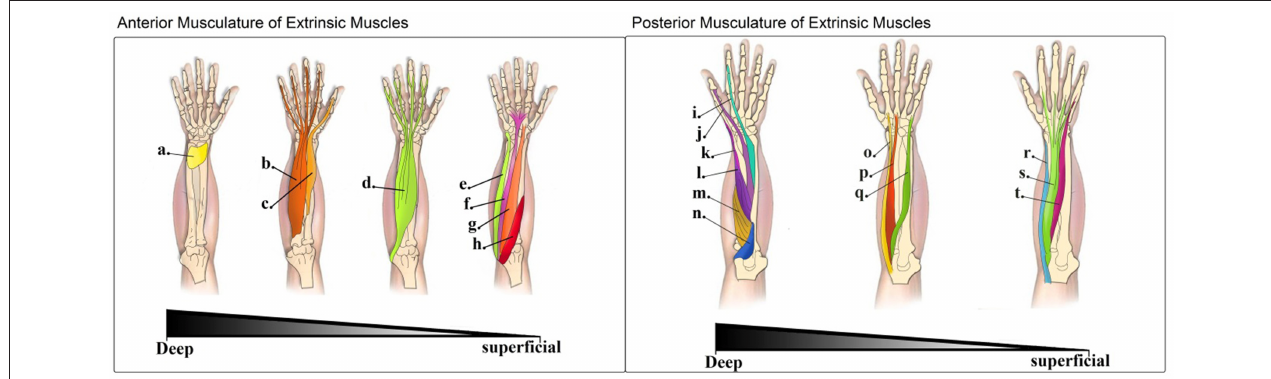
FIGURE 1 | Left: Muscles in the anterior compartment of extrinsic muscles (flexor muscles of the forearm)—The muscles of the anterior compartment of the forearm are depicted in this image from the deepest layer (left) to the most superficial one (right): (a). Pronator quadratus (PQ); (b). Flexor digitorium profundus (FDP); (c). Flexor pollicis longus (FPL); (d). Flexor digitorium superficialis (FDS); (e). Flexor carpi ulnaris (FCU); (f). Palmaris longus (PL); (g). Flexor carpi radialis (FCR); (h). Pronator teres (PT). Right: Muscles in the posterior compartment of extrinsic muscles (extensor muscles of the forearm)—The muscles of the posterior compartment of the forearm are depicted in this image moving from the deepest to the most superficial layer: (i). Extensor indicis (EI); (j). Extensor pollicis longus (EPL); (k). Extensor pollicis brevis (EPB); (l). Abductor pollicis longus (APL); (m). Supinator (S); (n). Anconeous (A); (o). Extensor carpi radialis longus (ECRl); (p). Extensor carpi radialis brevis (ECRb); (q). Extensor carpi ulnaris (ECU); (r). Brachioradialis (B); (s). Extensor digitorium (ED); (t). Extensor digiti minimi